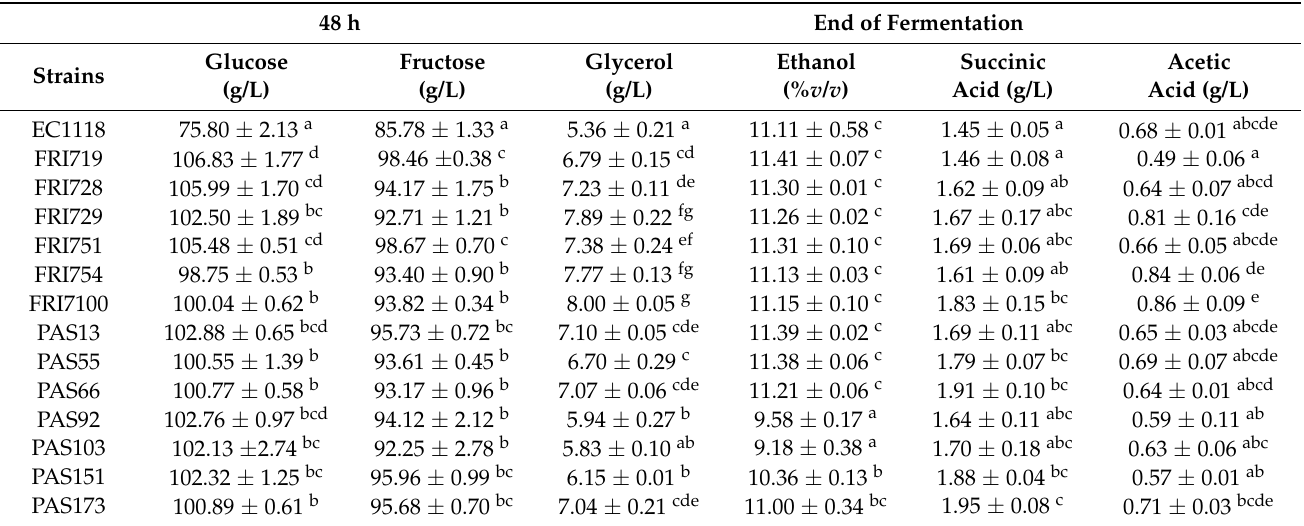
Table 2. Glucose and fructose residues at 48 h and concentrations of the main fermentation products at the end of sequential fermentations with S. bacillaris strains and S. cerevisiae EC1118 in Pinot grigio. 48 h